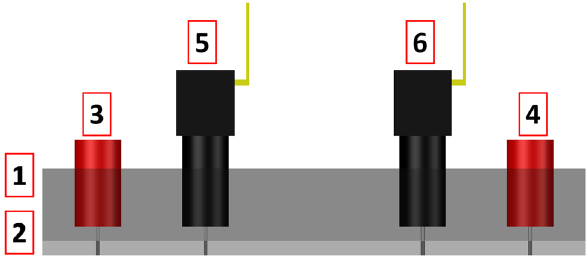
Fig. 1 Schematic diagram of a “Rheo-chip” microdevice. 1 Delivery module. 2 Microfluidic flow geometry. 3 Inlet. 4 Outlet. 5 and 6 Hon- eywell pressure